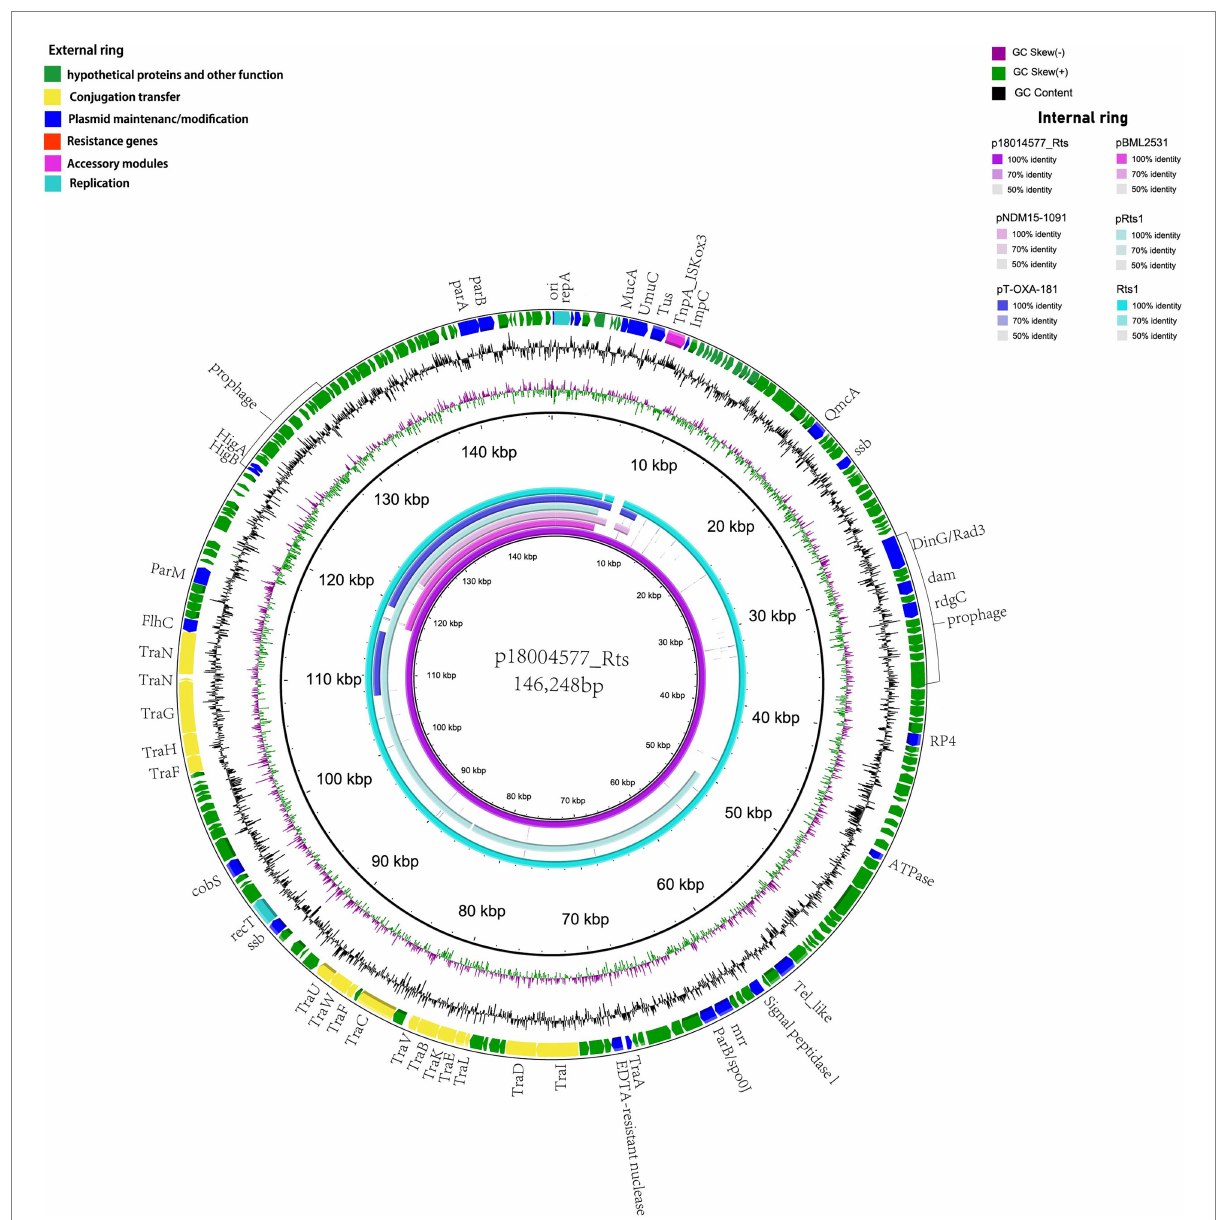
FIGURE 2 Structural comparisons of p18004577_Rts with the similar plasmids. The outer ring represents the CDSs of the reference sequence p18004577_ Rts. The internal six rings show the comparative analysis of plasmids pBML2531 (GenBank accession no. AP022376.1), pNDM15-1091 (GenBank accession no.CP012903.1), pRts1 (GenBank accession no. MN626604.1), pT-OXA-181 (GenBank accession no. NC_020123.1), and Rts1 (GenBank accession no. NC_003905.1) with